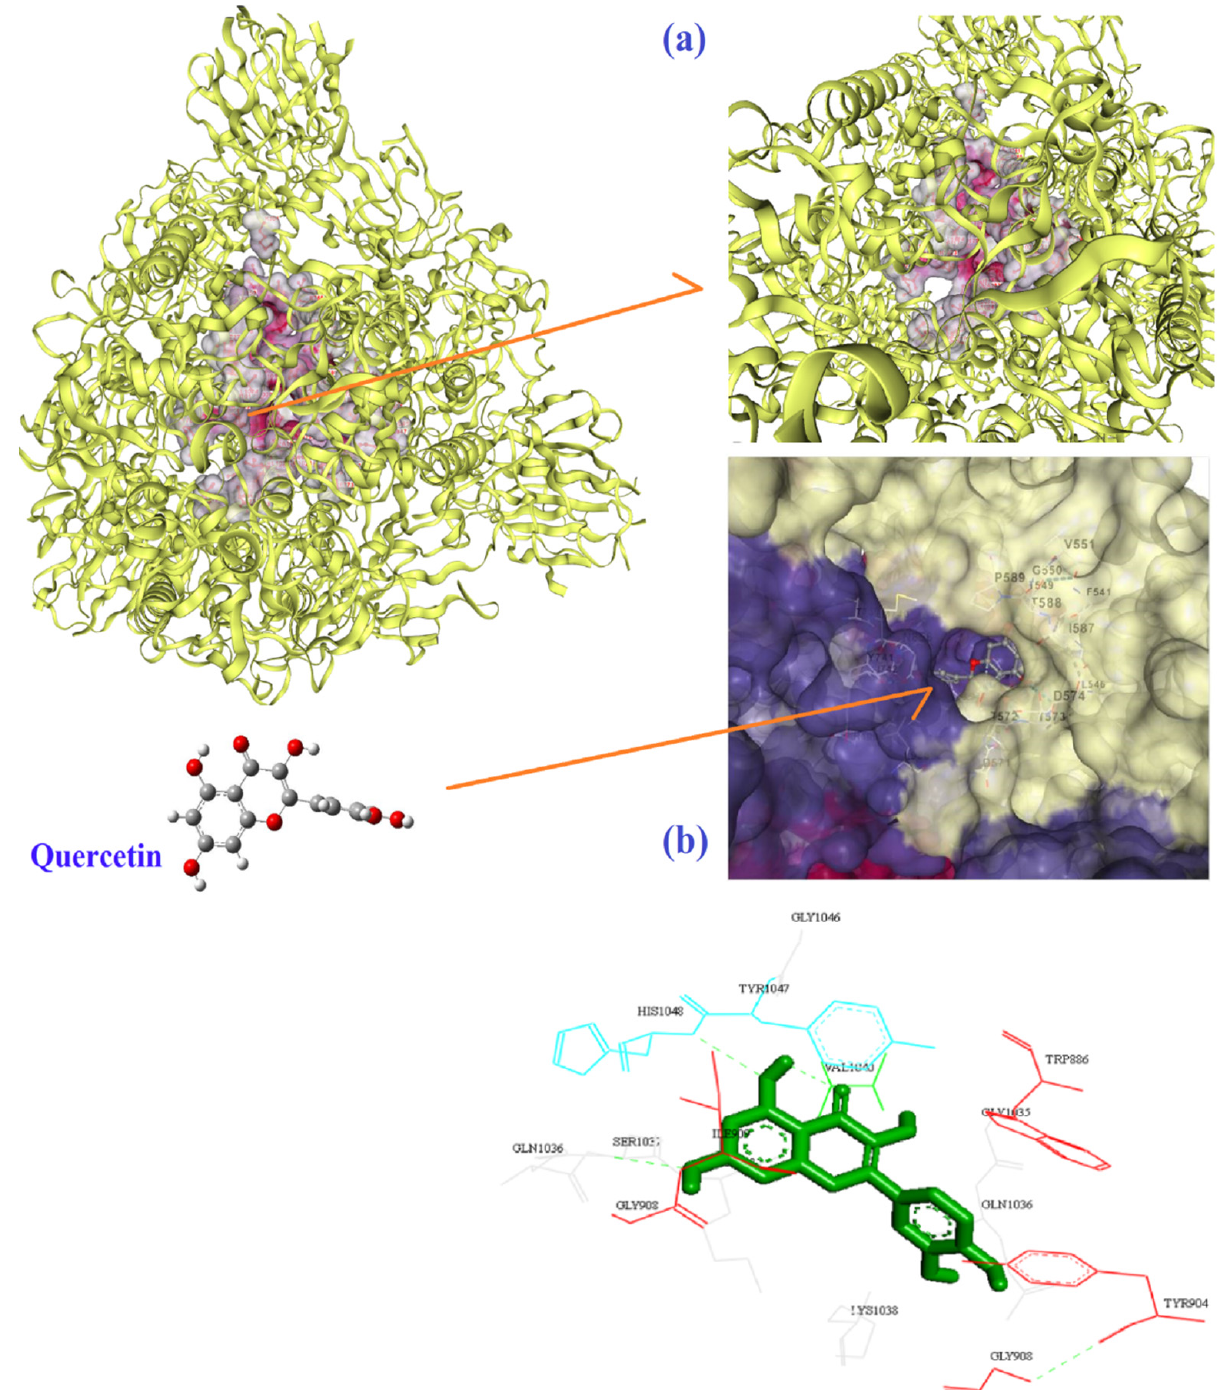
Figure 5. The best mode of the active site for the receptor of 6VSB ( a ) and its interaction with quercetin ( b ) according to the results of CB-Dock.